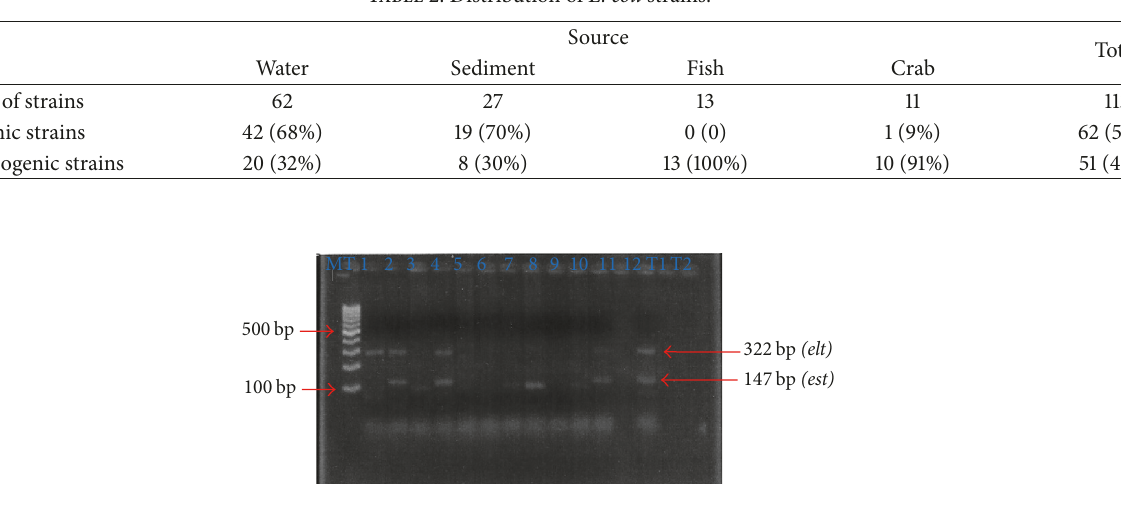
Figure2:Gelelectrophoresisprofileofdifferentvirulencegenesofthepotentialdiarrheagenic E. coli isolates.LaneMT:molecularsizemarker (100bp DNA ladder). Lane 1: elt ; lanes 2 and 4: elt and est ; lanes 3, 5, 6, 7, 9, 10, and 12: nonpathogenic E. coli ; lanes 8 and 11: est ; T1: positive control (est, elt) ; T2: negative control.